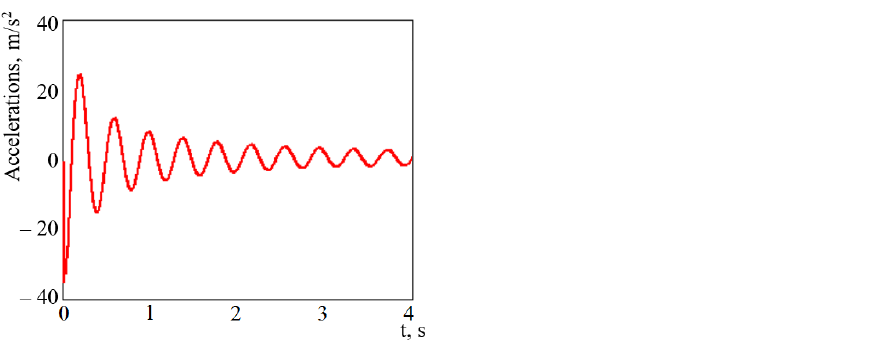
Figure 3. Accelerations on carrying structure of the open wagon under shunting impacts.